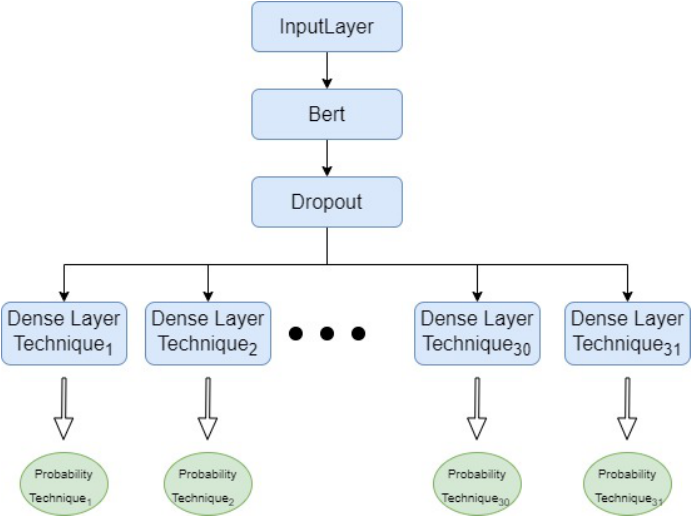
Figure 5. BERT-based architecture with multiple output layers.